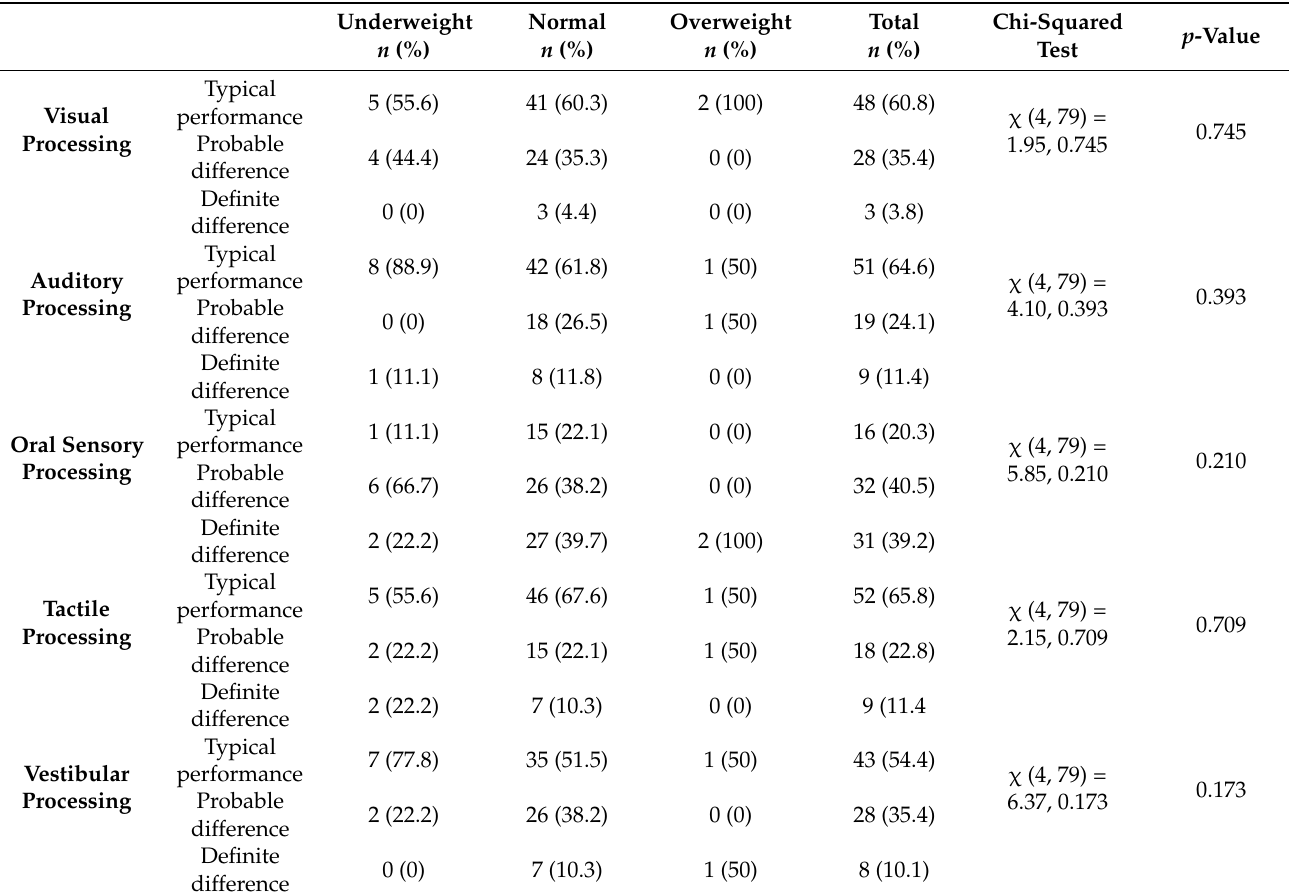
Table 2. Relationship between weight-for-age anthropometric index (z-score) and sensory processing.